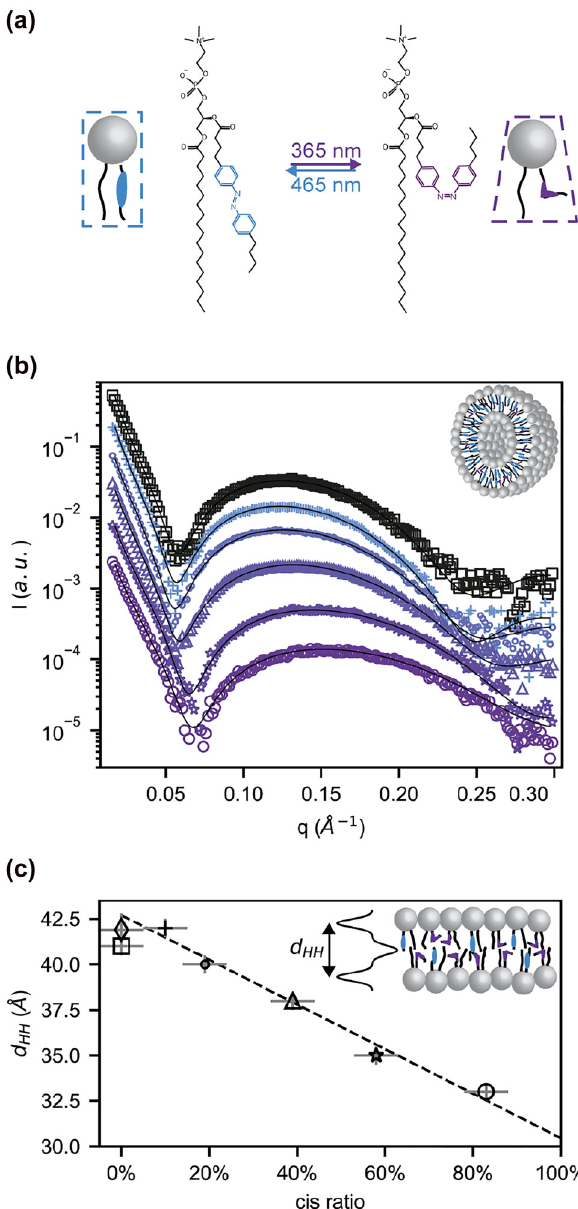
Figure 1: X-ray structural data of photoswitchable membranes. (a) Schematicrepresentation of the chemicalstructureof the azo-PC photolipids used in this study and their trans and cis con fi guration. (b) SAXS intensities for unilamellar azo-PC vesicles prepared from prede fi ned trans to cis ratios: Dark-adapted state (100:0), (90:10), (81:19), (61:39), (42:58) and (17:83) are shown as squares, crosses, dots, triangles, stars, and circles. Intensities are vertically offset for clarity. (c) Head-to-head distance ( d HH ) of azo-PC membranes as function of the percentage of azo-PCs in cis isomerization state are shown with the same symbols as in (b). Additionally, the mean value of d HH for the dark-adapted photostationary states obtained from azo-PC SUVs in DI water (Figure 2b) is shown as diamond. The linear fi t of d HH in dependence of cis isomer percentage is indicated as dashed line. See Supporting Information (section S8) for details.